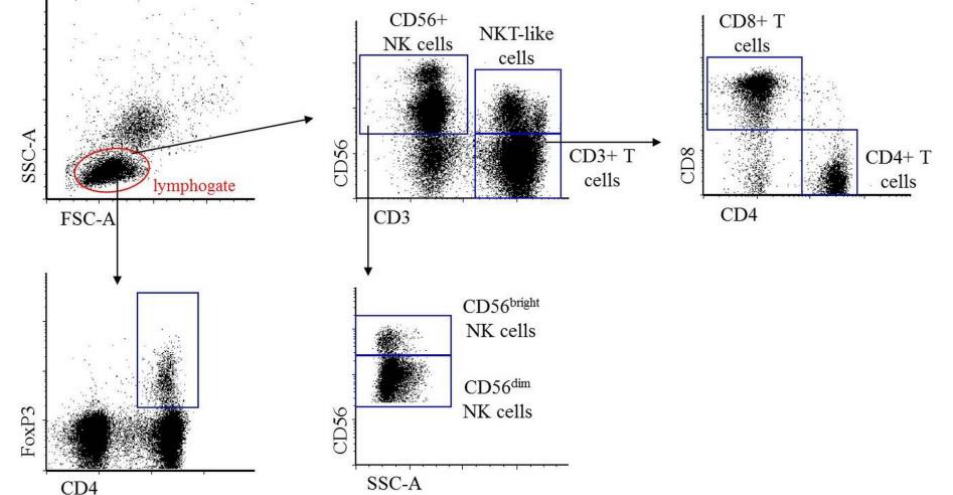
Figure 1. Gating strategy for flow cytometry analysis. Selection method of the investigated peripheral and peritoneal CD3 + T, CD4 + T, CD8 + T, CD4 + Treg, CD56 + NK, CD56 dim NK, CD56 bright NK, and NKT-like immune cell subpopulations.